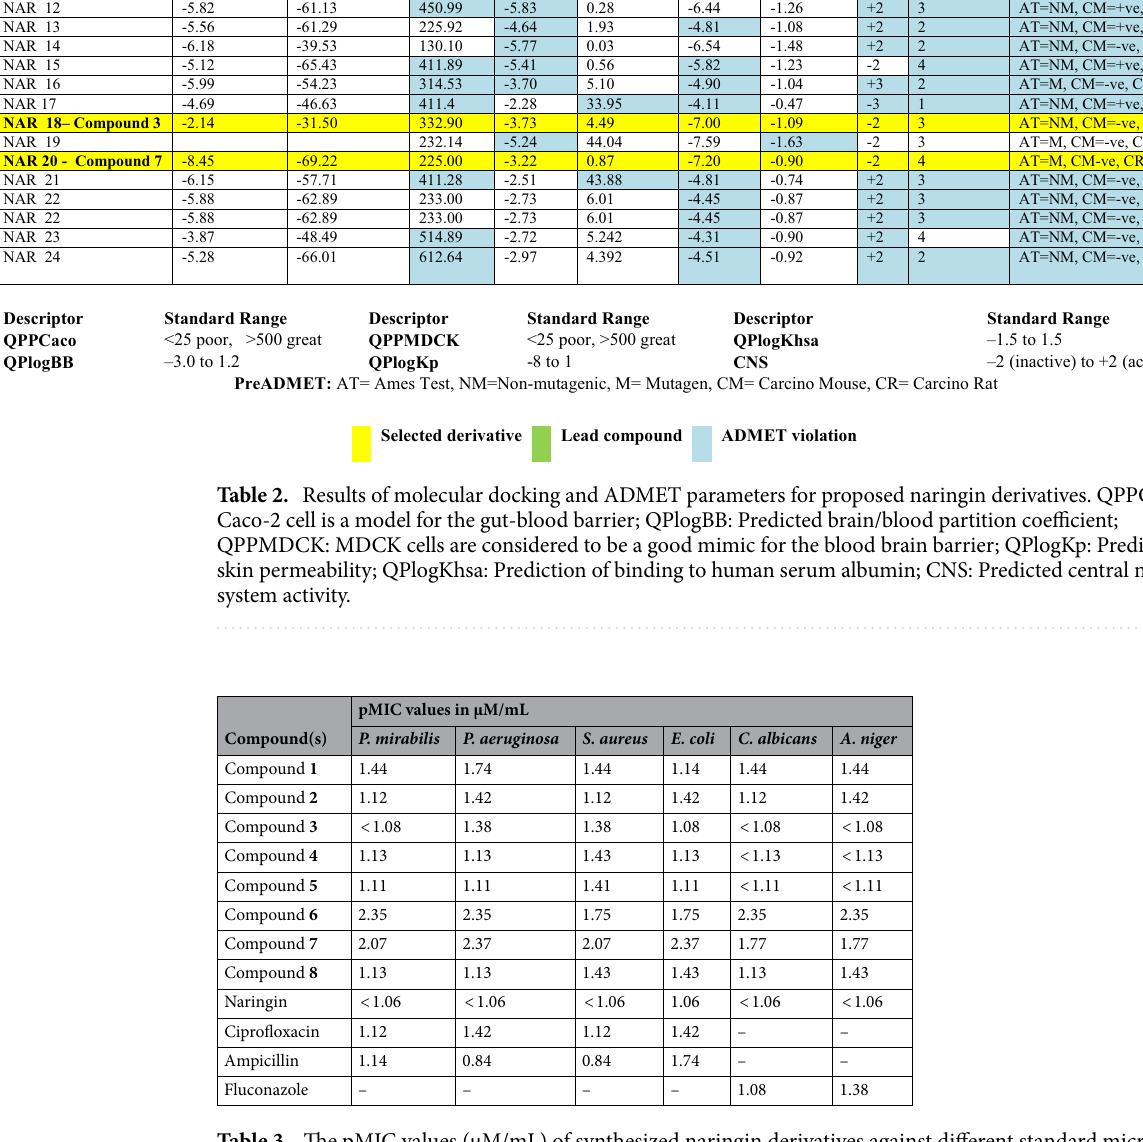
Table 3. The pMIC values (µM/mL) of synthesized naringin derivatives against different standard microbial strains.